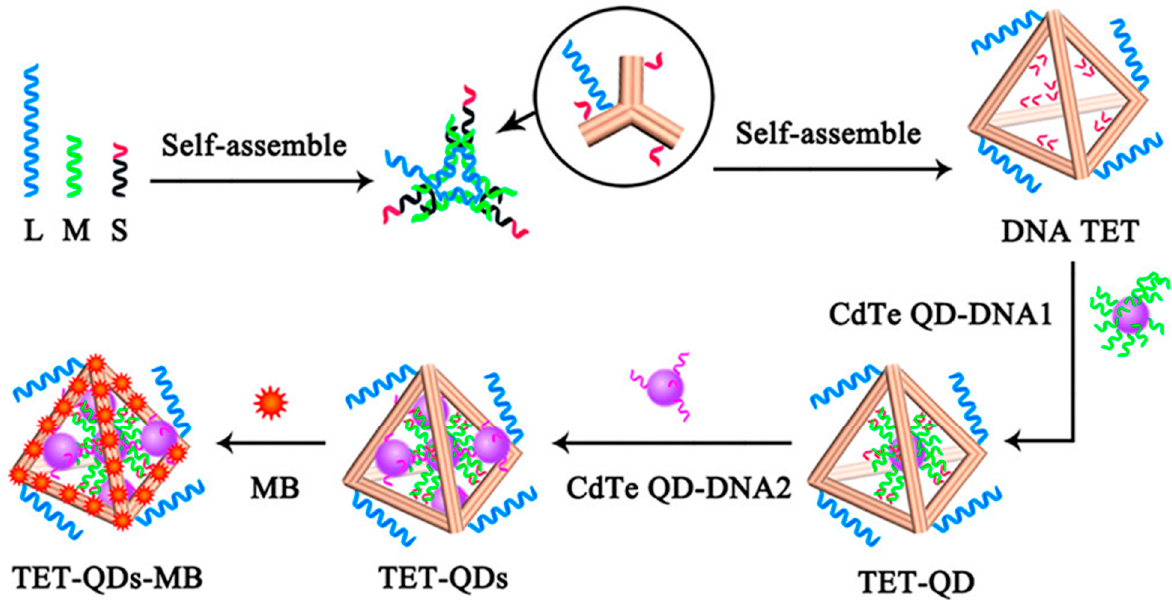
Figure 7. The DNA tetrahedron served as the immobilized template of CdTe QDs-Methylene Blue for photoelectrochemical detection. Reprinted (adapted) with permission from [155]. Copyright (2018) American Chemical Society.